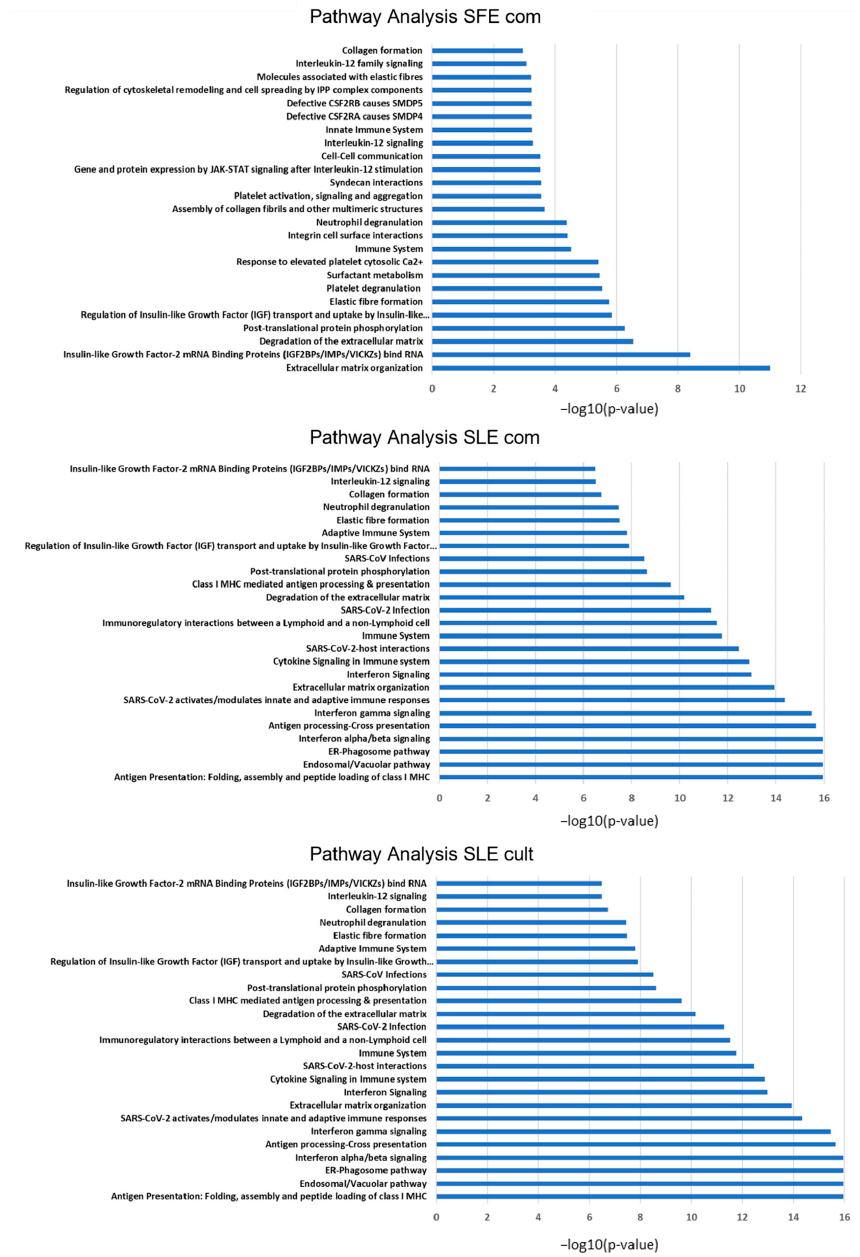
Figure 5. Bar graphs showing the pathway analysis that was performed using the Reactome pathway database in TNF α -activated MSCs treated with the C. vulgaris extracts. Secretome from SFE com-treated MSCs is depicted in the top panel, mid panel is for the SLE com, and bottom panel for the SLE cult samples. The length of the bars is relative to the statistical significance ( − log of the p value).